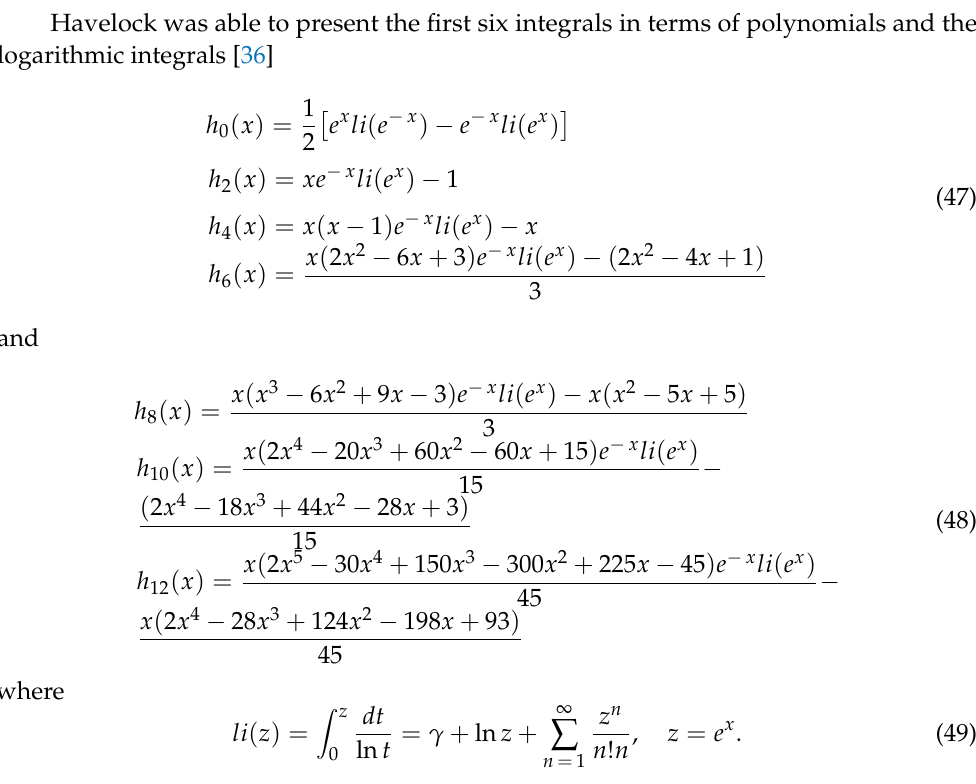
Figure 4. Havelock functions with begative integer orders as a function of argument x